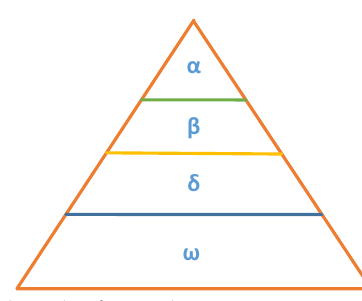
Fig. 3 The hierarchy of grey